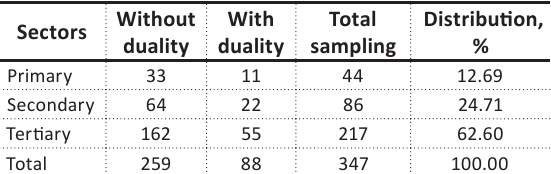
Table 1. Distribution of the